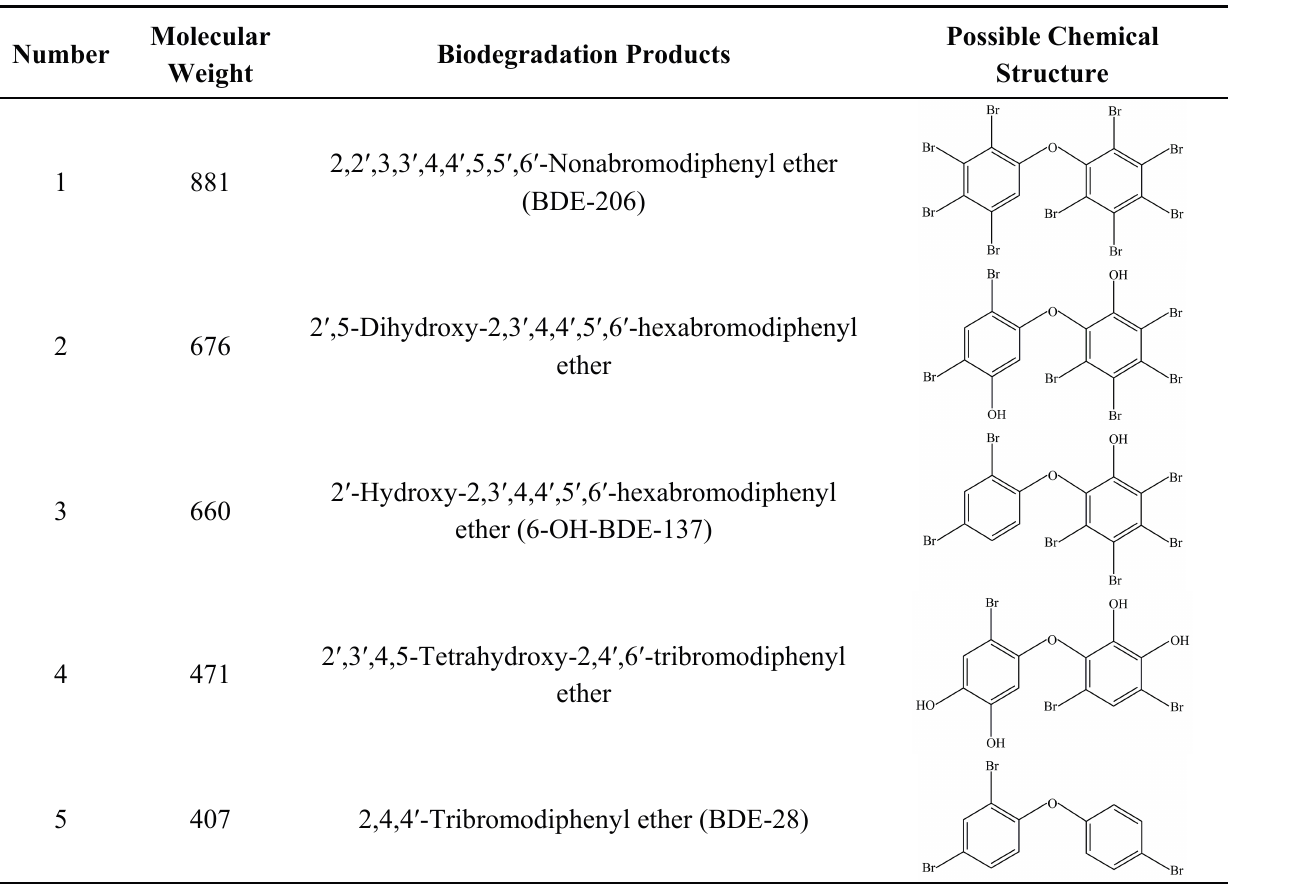
Table 2. Possible chemical structures of BDE-209 biodegradation products identified by GC-MS analysis in the biodegradation system of crude enzyme